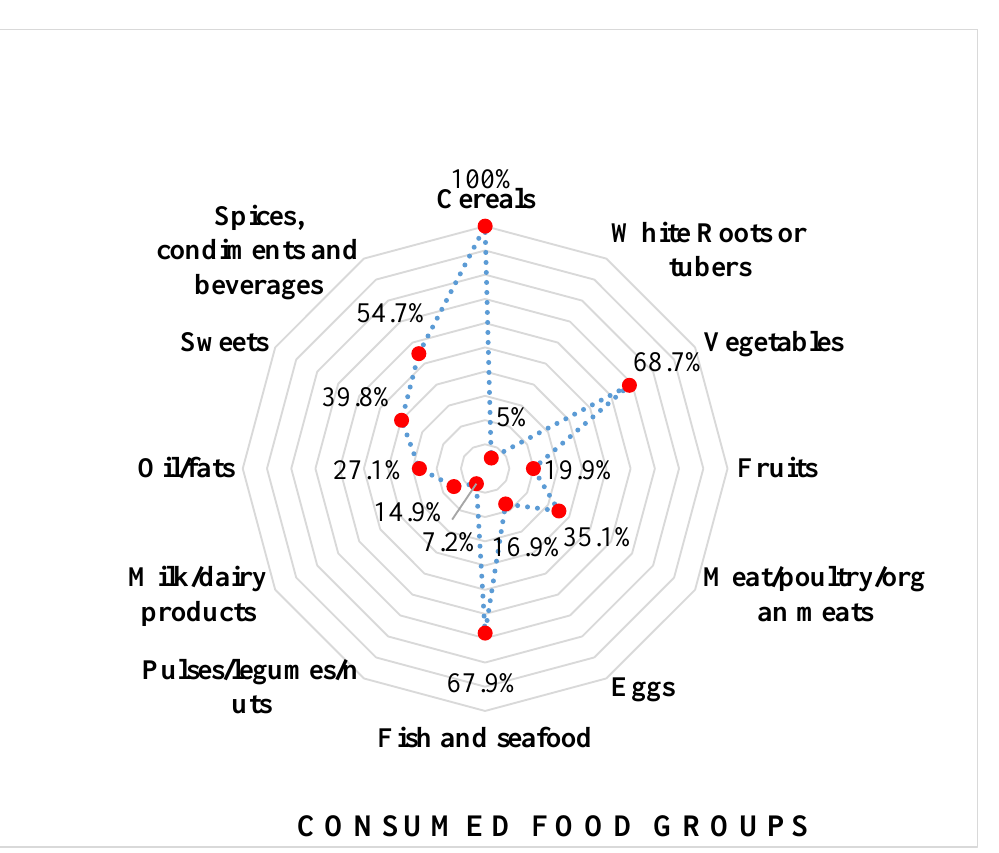
Figure 2. Food consumption pattern of Khmer minority households by the number of foods consumed (%).